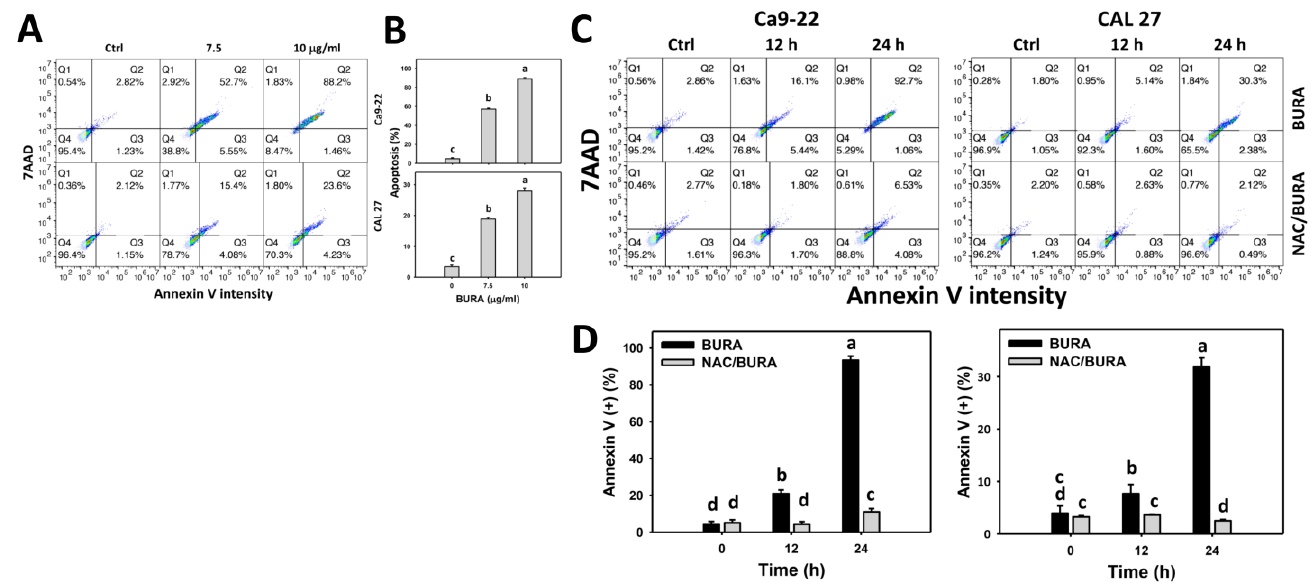
Figure 3. BURA causes apoptosis in oral cancer cells. ( A , B ) Annexin V pattern and quantification. Oral cancer cells (Ca9- 22 and CAL 27) were treated with BURA (control (0.1% DMSO), 7.5 μg /mL (25.3 μM), and 10 μg /mL (33.8 μM), 24 h). Annexin V (+)/7AAD (+/ − ) populations (%) were counted to apoptosis (%). ( C , D ) NAC effect on annexin V pattern and quantification. After NAC treatment (10 mM, 1 h), cells were treated with BURA (10 μg /mL) for 0 (control), 12 and 24 h. Data, mean ± SD ( n = 3). Data top-labeled with non-overlapping lower-case letters differ significantly according to multi-comparisons ( p < 0.05).